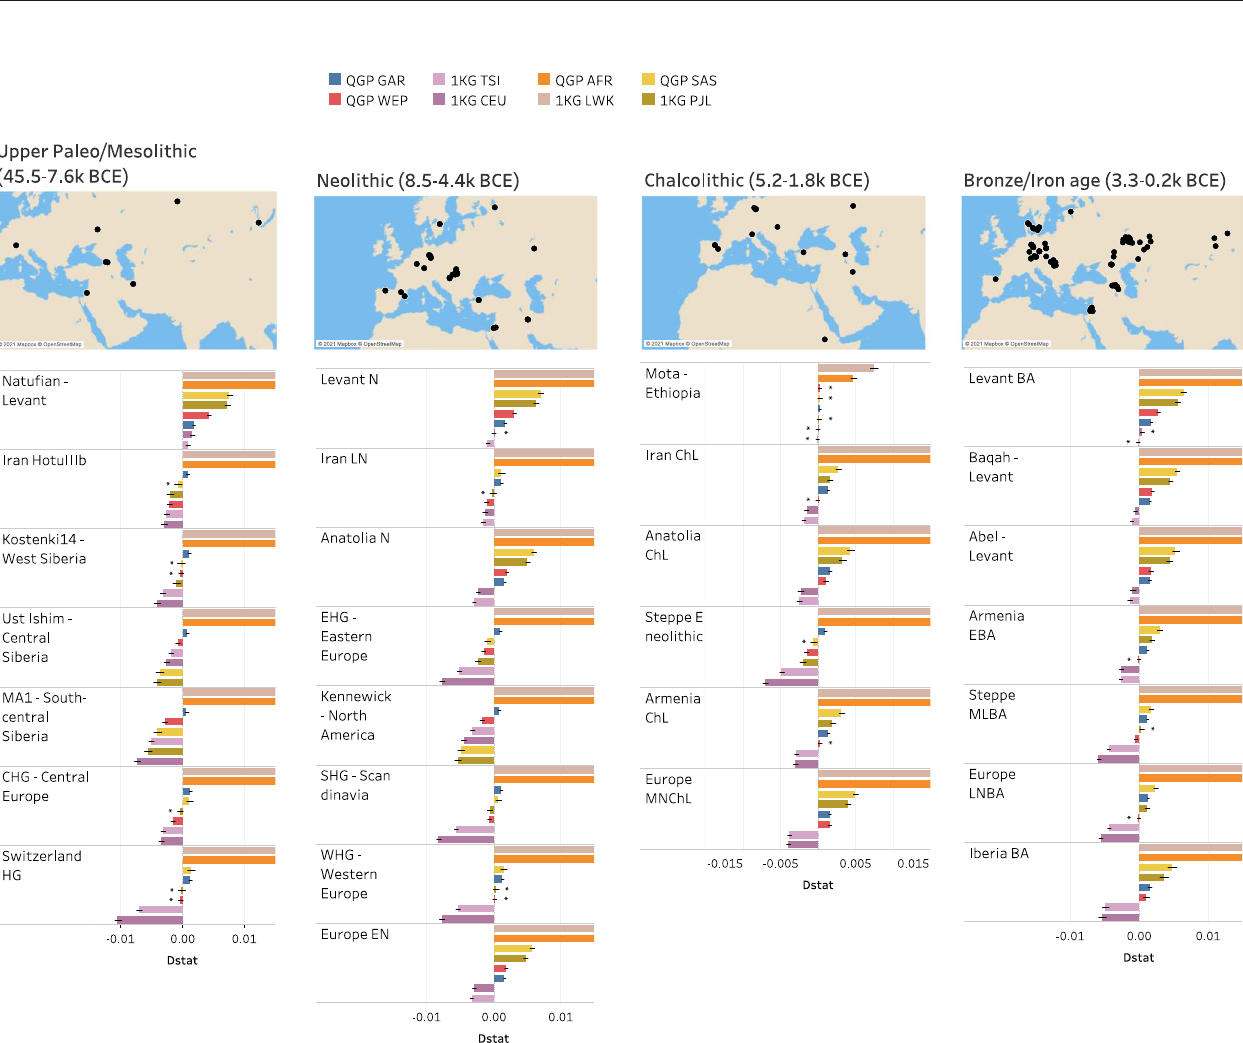
Fig. 4 Shared ancestry with ancient human populations from various archeological periods. Bar plots showing D-statistic for the contribution of various ancient human genomes to PAR ancestry relative to other QGP and world populations, inferred with Patterson ’ s D-statistic (Dstat). Results are grouped by archeological periods. The maps show the geographical locations of the corresponding ancient genomes. The dates refer to estimated time range of the ancient genomes (Dates for individual genomes are found in Supplementary Material). D-statistics values with low absolute Z score (<3) are highlighted with *. Black lines at the end of bars indicate 95% con fi dence intervals. Negative D-statistic value imply higher introgression with PAR relative to other tested populations while positive values imply the opposite. For clarity, bars for QGP AFR and 1KG LWK are shown up to 0.01 (They extend to maxima of 0.03 and 0.05 respectively). Numbers of samples used for QGP are AFR n = 179, GAR n = 2338, SAS n = 40, WEP n = 1390 and for 1KG are CEU n = 99, LWK n = 99, PJL n = 96, TSI n = 107. Abbreviations of 1KG populations are explained in Supplementary Table 2. Source data are provided as a Source Data fi